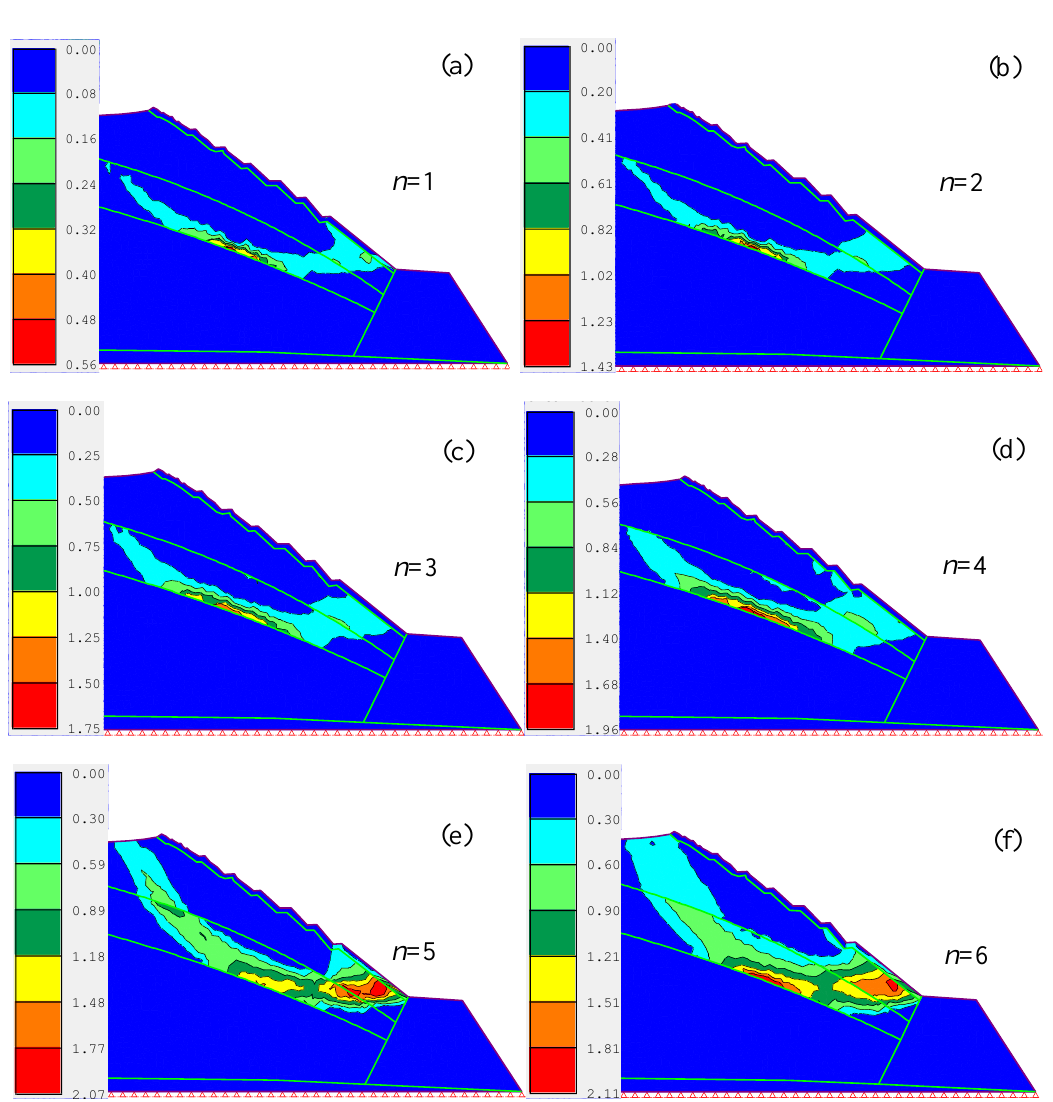
Figure 6. Diagram of shear stress after different DW cycles ( n is the number of DW cycles). ( a ) n = 1; ( b ) n = 2; ( c ) n = 3; ( d ) n = 4; ( e ) n = 5; ( f ) n = 5.